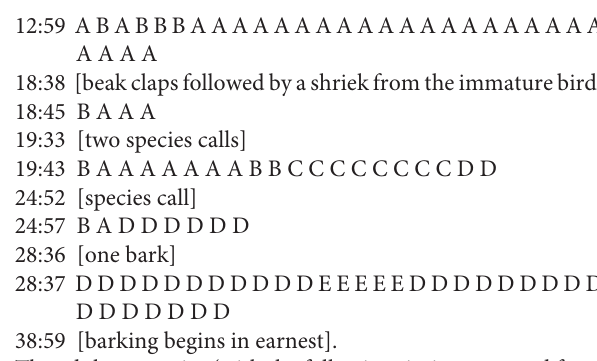
vocal activity is then much reduced whilst the birds are